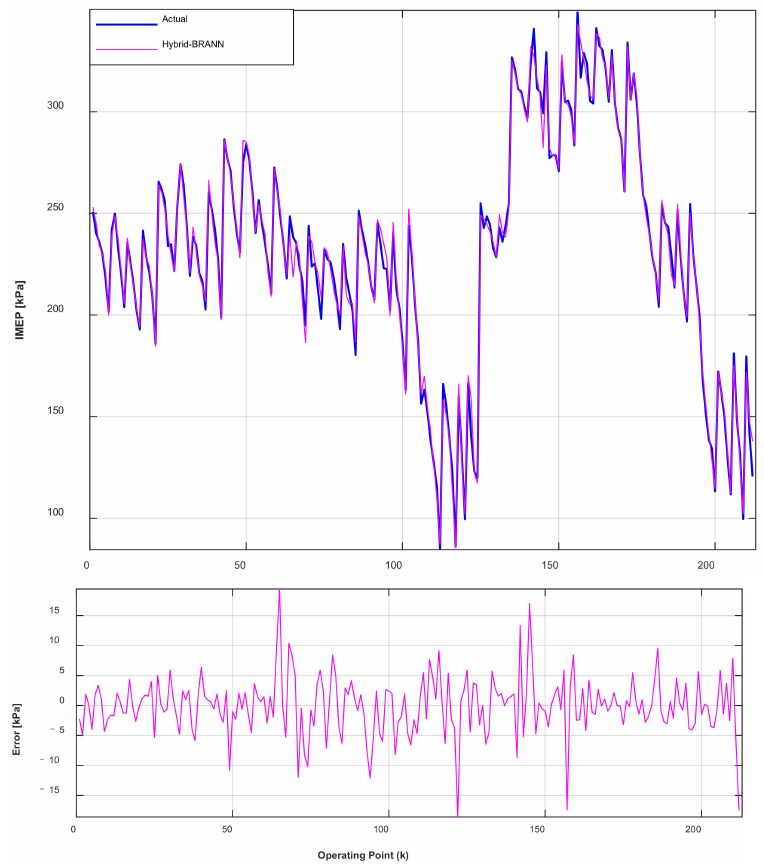
Figure 20. Comparison of the hybridized IMEP BRANN model to the actual